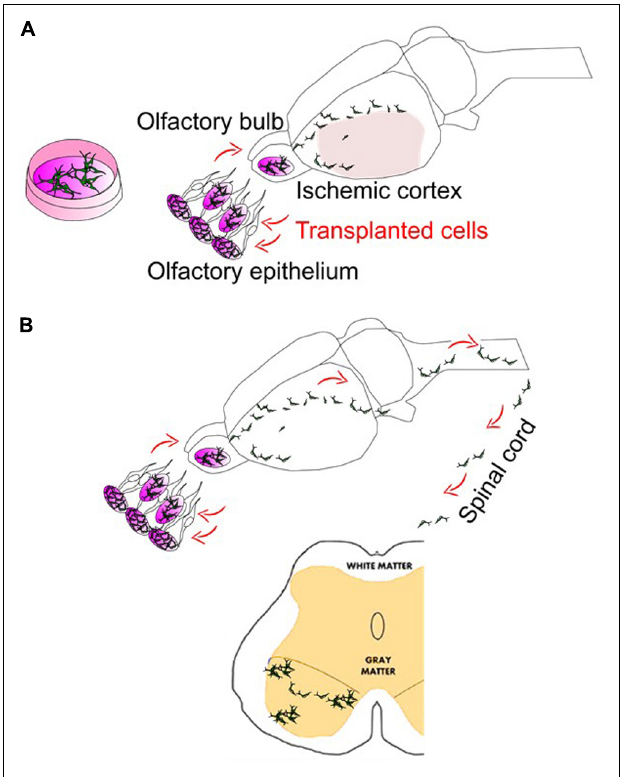
FIGURE 2 | Intranasal delivery to bypass the BBB in stroke and ALS. (A) Intranasal delivery of stem cells following cerebral ischemia can show the robust deliveries into the mouse/rat brains. In addition, although not shown here, stem cells intranasally delivered may hold the potentials and repair the vasculature of the brain (Sun et al., 2015). (B) The cells intranasally delivered have demonstrated the ability to reach the spinal cord. Meanwhile, there are many trials on the use of spinally targeted cellular treatment for amyotrophic lateral sclerosis (ALS) or spinal cord injury (SCI), which have reached phase I and phase II clinical stages. Intranasal delivery of drugs such as growth factors or stem cell-derived exosomes have been recently tested in ALS mice models (Zhong et al., 2017; Bonafede et al.,